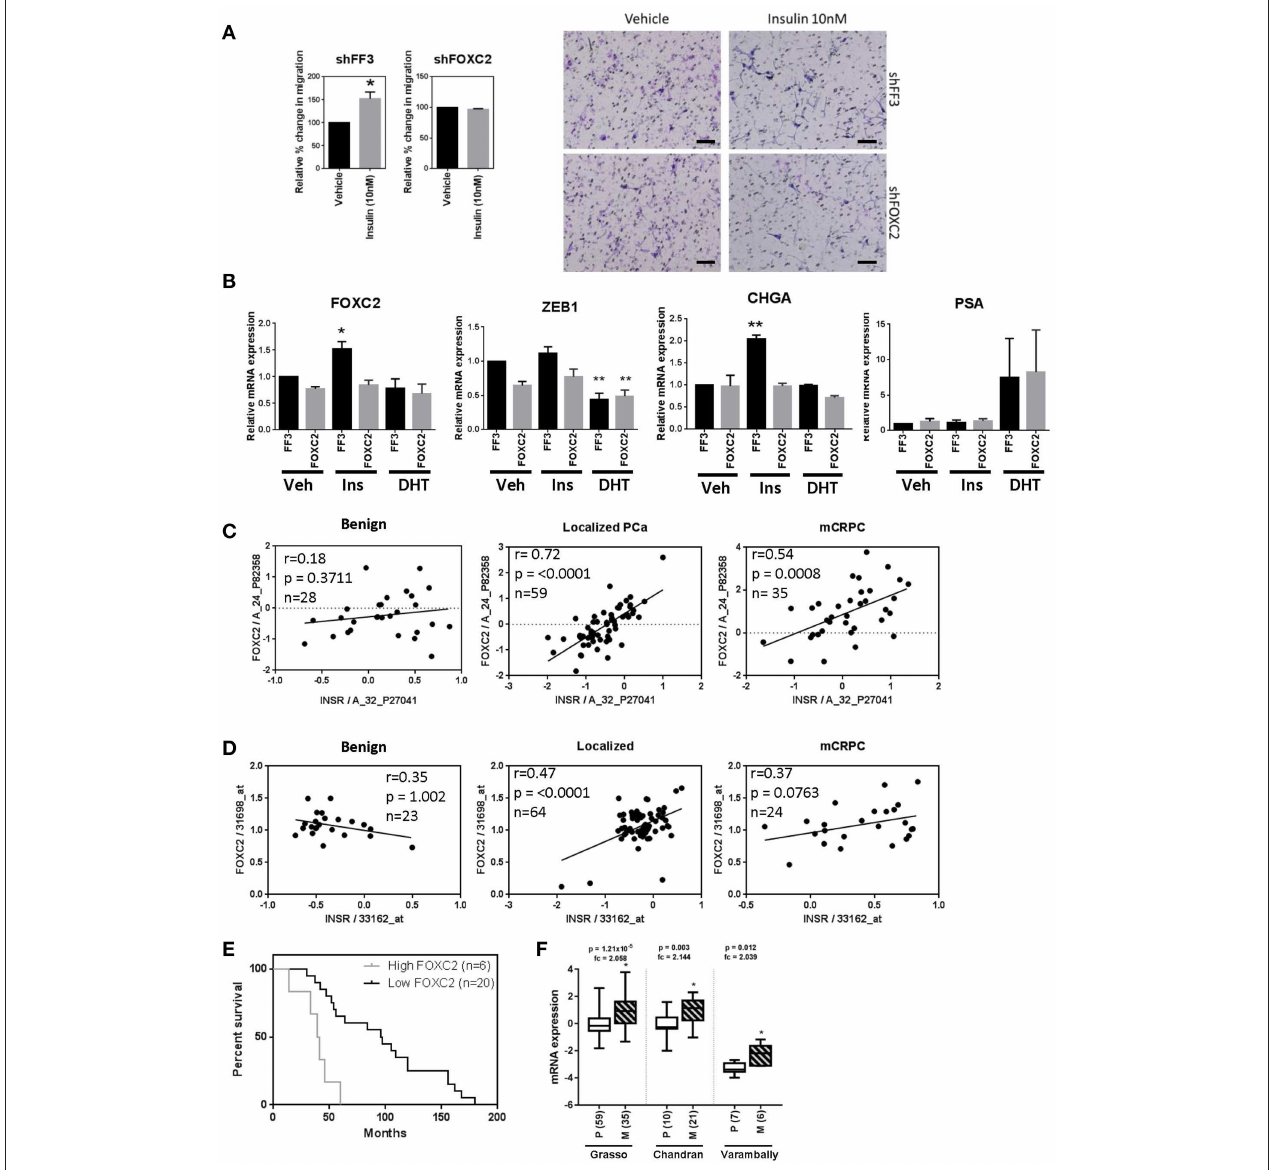
FIGURE 7 | FOXC2 knockdown blocks migration and plasticity phenotype and FOXC2 expression significantly correlates with insulin receptor expression in PCa patient samples. (A) LNCaP cells with constitutive FOXC2 knockdown did not migrate through transwell in response to insulin treatment, unlike their control counterparts with scramble knockdown (Scale bars = 100 µ m). (B) LNCaP cells with constitutive FOXC2 knockdown were also unable to up-regulate several EMT and NE markers in response to insulin (Ins) treatment compared to vehicle (Veh), unlike FF3 control cells. Knockdown of FOXC2 prevented insulin induced rise in Zeb1. Linear regression shows a significant positive association between FOXC2 and INSR in PCa patients with localized and mCRPC tumors in both (C) Grasso and (D) Yu datasets. (E) Kaplan-Meier survival curve shows FOXC2 expression is significantly associated with overall survival in mCRPC patients with wild type AR amplification mutation in Grasso. Median overall survival is significantly reduced by 62% in patients with metastatic tumors expressing high levels of FOXC2 compared with patients with low level of FOXC2 expression (F) Box-plots showing FOXC2 mRNA is significantly increased in the metastatic PCa tumors (M) (patient numbers in brackets) compared to primary tumors (P) in three datasets, accessed using Oncomine TM (* p < 0.05, ** p < 0.01, One-way ANOVA, ± SEM with vehicle as